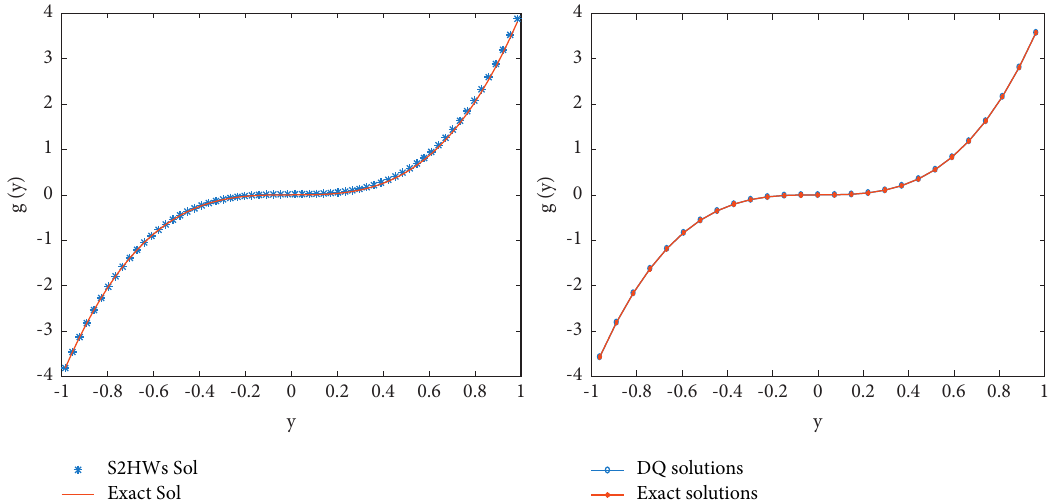
Figure 3: Exact, S2HW, and LIDQT solutions of problem (44) for the parameters R � 1 . 5 , α � 1 , φ � 0 . 9 (a